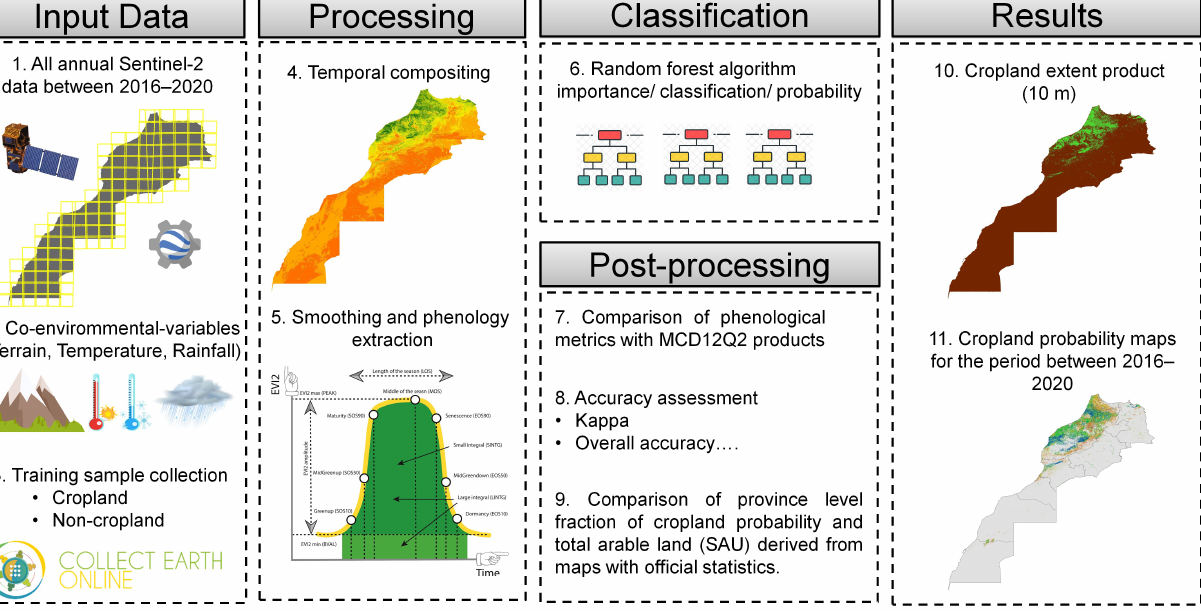
Figure 2. Flow chart of cropland and its probabilities mapping through high resolution images, phenological cycle depiction and machine learning technique on the GEE